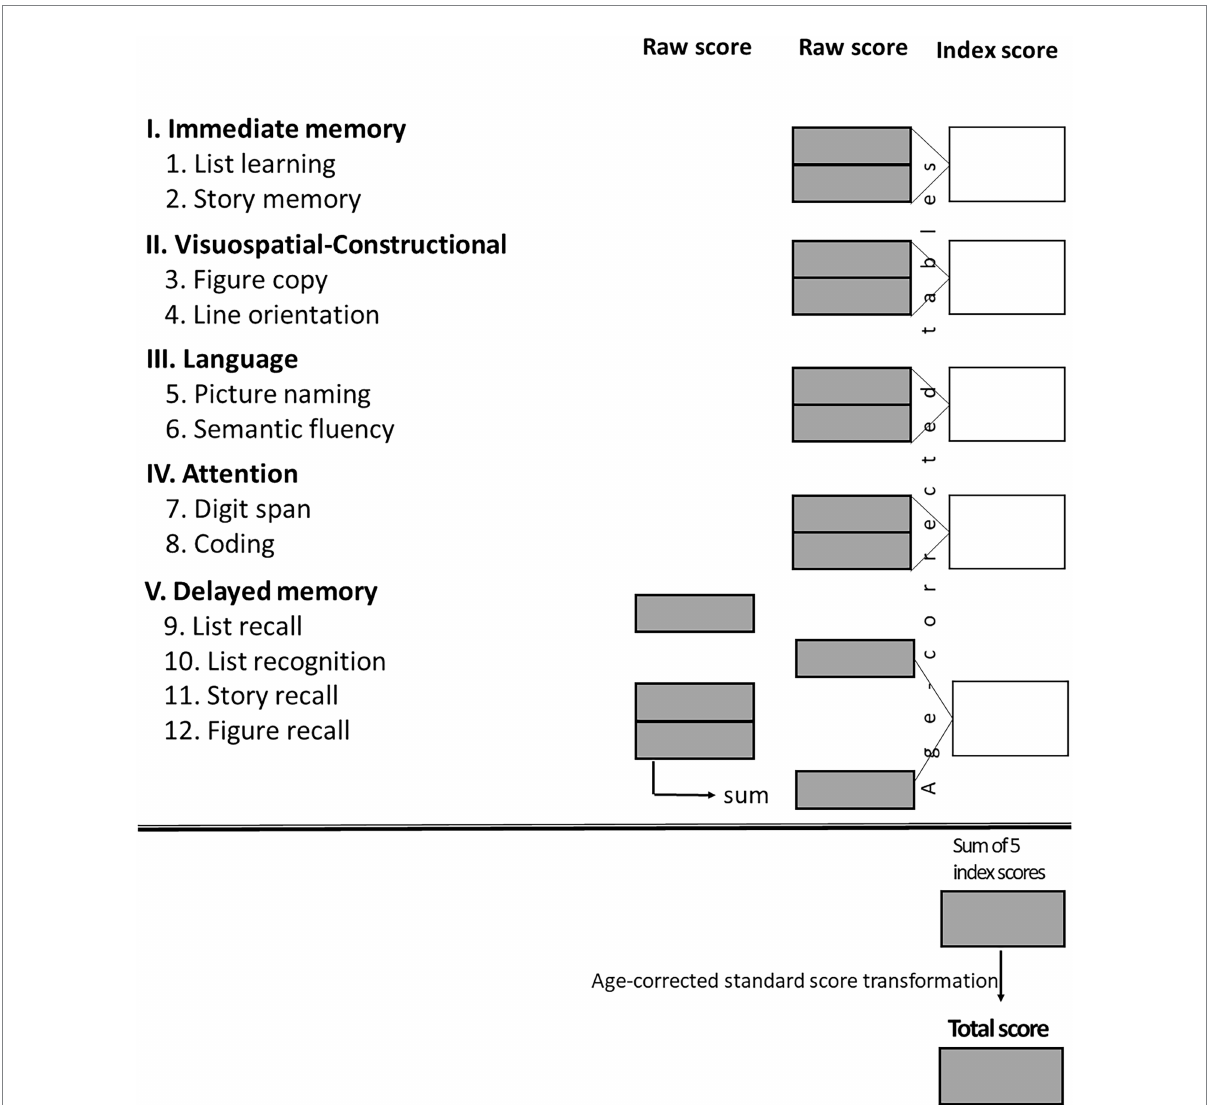
FIGURE 2 Score conversion sheet with the five domains (I–V) and the twelve subtests (1–12). The sum of the 5 index scores results in a final RBANS-H score which is transformed into an age-corrected standardized score (“total score”) with a mean of 100 and a standard deviation (SD) of 15 points – average cognitive status is considered 100 points according to a Gaussian distribution, score which equates to the 50th percentile (Claes et al.,